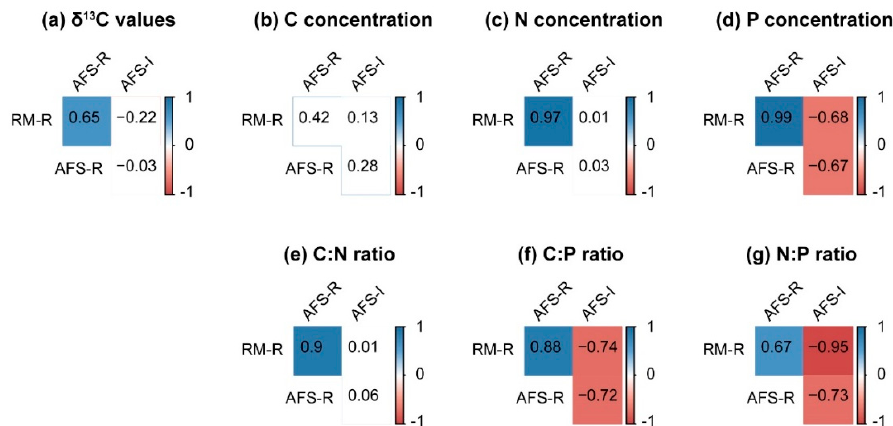
Figure 6. The Pearson correlation-based similarities between RM-R, AFS-R, and AFS-I, which were analyzed through the ( a ) leaf δ 13 C values; ( b ‒ d ) leaf C, N, and P concentrations; and ( e ‒ g ) leaf C/N, C/P, and N/P ratios of the rubber trees and their intercrops. The color indicates the sign of the correlation (blue indicates a positive correlation, and red indicates a negative correlation). All the correlation coefficients in the red and blue boxes were significant ( p < 0.05).